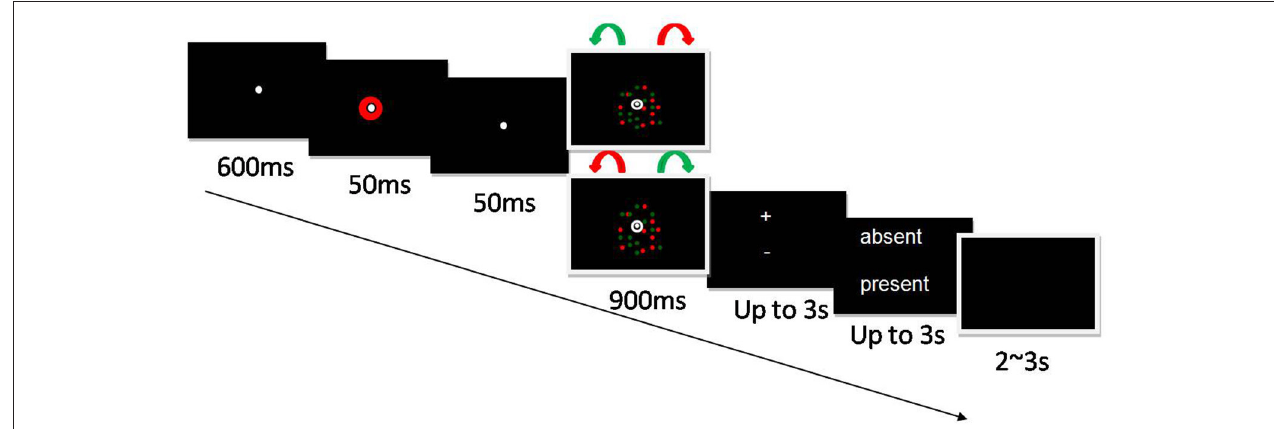
FIGURE 1 | Experimental design. Two populations of dots, one red and one green, were shown on each trial. Each population was composed of 50 dots, and all targets were in an annulus 1–3 dva from fixation. One colored population rotated clockwise and the other counterclockwise. Which color rotated in which direction was randomly assigned. Following a 600ms fixation screen, a 50ms colored cue, and then another 50ms fixation screen, the colored dots were shown rotating for 900ms. On 87% of trials, one of the two dot populations either sped up or slowed down at an acceleration/deceleration rate determined by a prior one-up-one-down staircase procedure that led to a 50% detection rate for attended colors for each participant (see below). The color of the population that changed speed was congruent with the color of the cue in only half of the trials. This seemingly “meaningless” cue is used to manipulate rapid and reflective exogenous attention. On the remaining 13% of trials, the dots rotated at their original, uniform velocity (6 dva/s). Subjects were asked to answer two successive questions: first, whether there was an acceleration or deceleration of the target stimuli (two-alternative forced choice), and second, whether they thought one dot population moved at a variable speed.